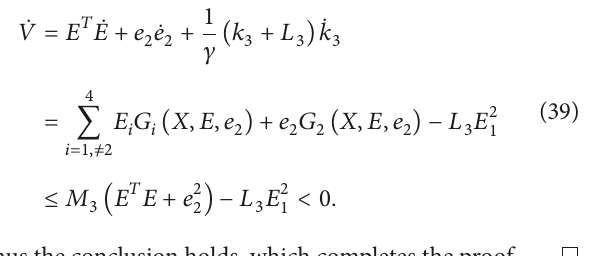
Similarly, numerical simulation is carried out with the following initial conditions: 𝑥 1 (0) = 1 , 𝑥 2 (0) = 2 , 𝑥 3 (0) = (0) = −1, 𝛾 = 1 . Figure 9 displays that 1 , and 𝑘 1